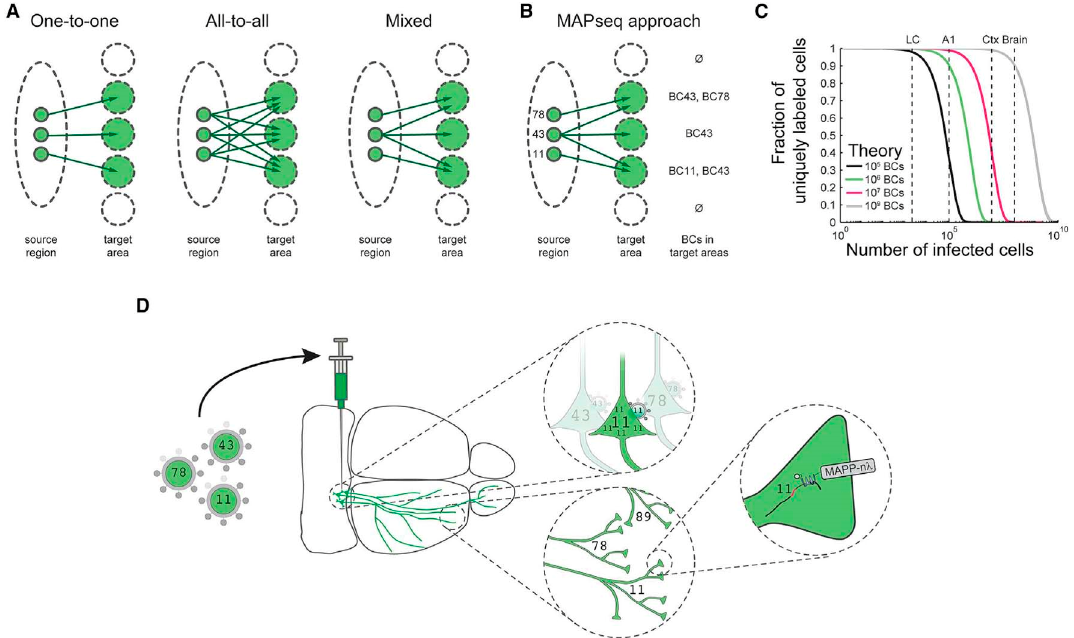
Figure 3. Multiplexed Analysis of Projections by Sequencing (MAPseq) procedure for mapping single-neuron projections. ( A ) Various underlying projection patterns develop identical bulk mapping. ( B ) Random labeling of single neurons with barcodes. ( C ) The expected fraction of uniquely labeled cells is given by F = (1-1/N)(k-1), where N is the number of barcodes and k is the number of infected cells, assuming a uniform distribution of barcodes. (A1, primary auditory cortex; Ctx, neocortex). ( D ) In MAPseq, neurons are infected at low MOI with a barcoded virus library. Barcode mRNA is expressed, trafficked, and can be extracted from distal sites as a measure of single-neuron projections. Reprinted with the permission from [61].